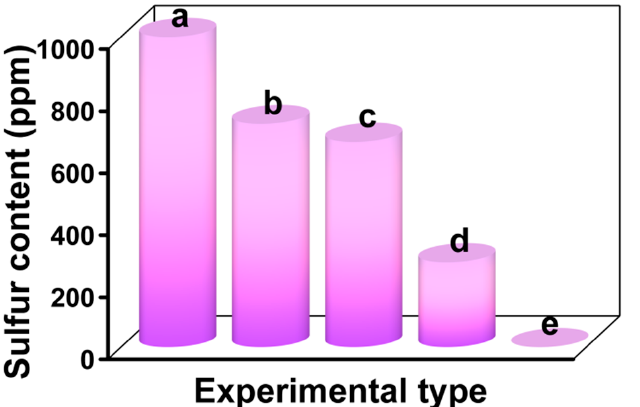
Figure 12. E ff ects of di ff erent desulfurization systems on sulfur removal: sulfur content before the reaction (a), extractive desulfurization of pure [BMIM]BF 4 (b), unmodi fi ed [BMIM]Cl-based MCF in [BMIM]BF 4 (c), ECODS of phosphomolybdic acid in[BMIM]BF 4 (d), and ECODS of